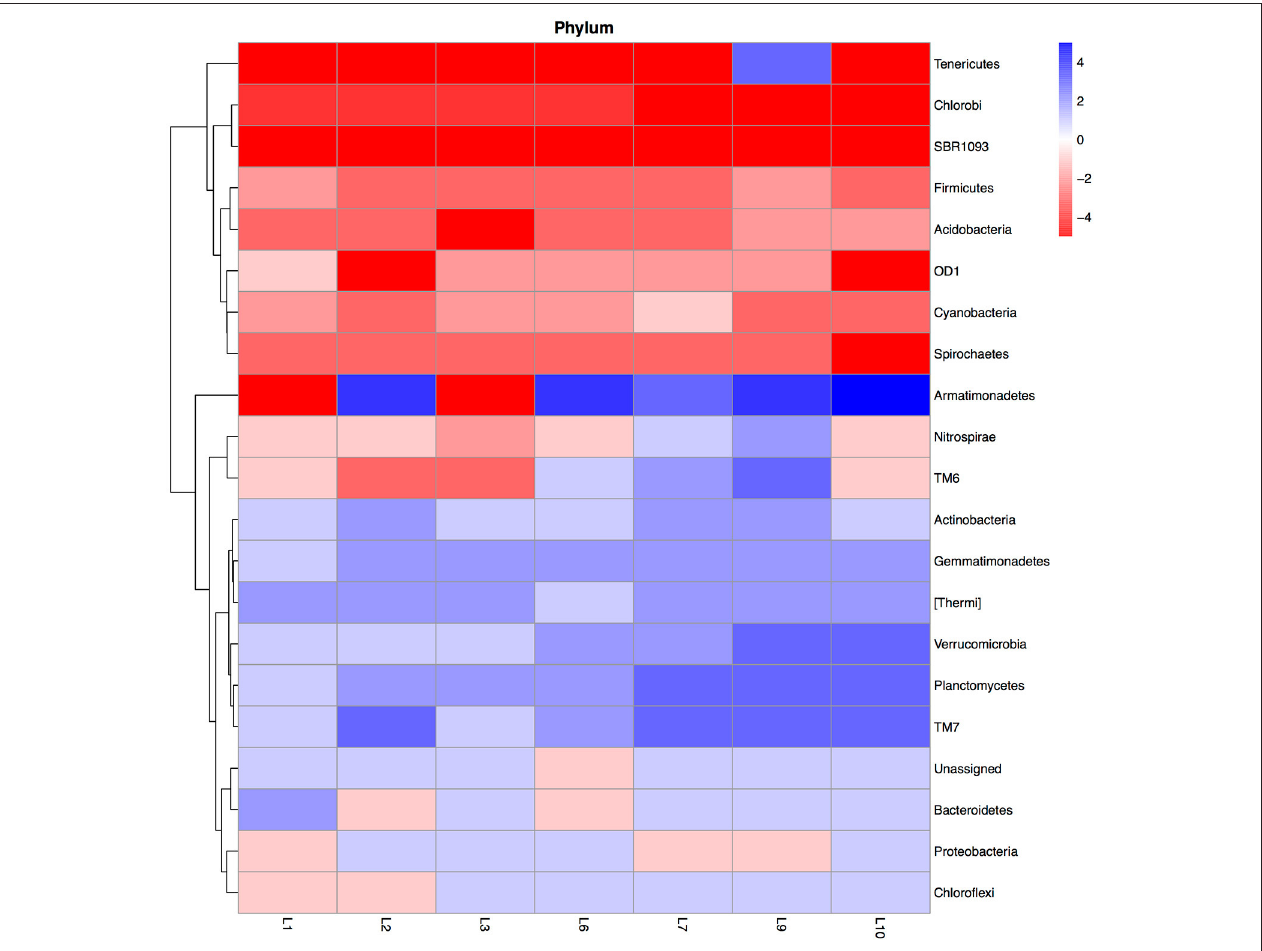
FIGURE 1 | Heatmap of the ratio between the relative abundance of the different bacterial phyla in the unflooded soil vs. that of the soil flooded once (1), twice (2), trice (3), six (6), seven (7), nine (9), or ten times (10). The ratio was calculated as: (relative abundance of the bacterial group in the flooded soil—relative abundance of the bacterial group in the unflooded soil)/relative abundance of the bacterial group in the unflooded soil. The ratios were categorized with value − 5: ratio between the flooded and unflooded soil ≤ − 0.99, value − 4: ratio > − 0.99 ≤ − 0.96, value − 3: ratio > − 0.96 and ≤ − 0.80, value − 2: ratio > − 0.80 ≤ − 0.50, value − 1: ratio > − 0.50 > 0, value 0: ratio = 0, value 1: ratio > 0 and < 1, value 2: ratio ≥ 1 and < 4, value 3: ratio ≥ 4 and < 24, value 4: ratio ≥ 24 and < 99, value 5: ratio ≥